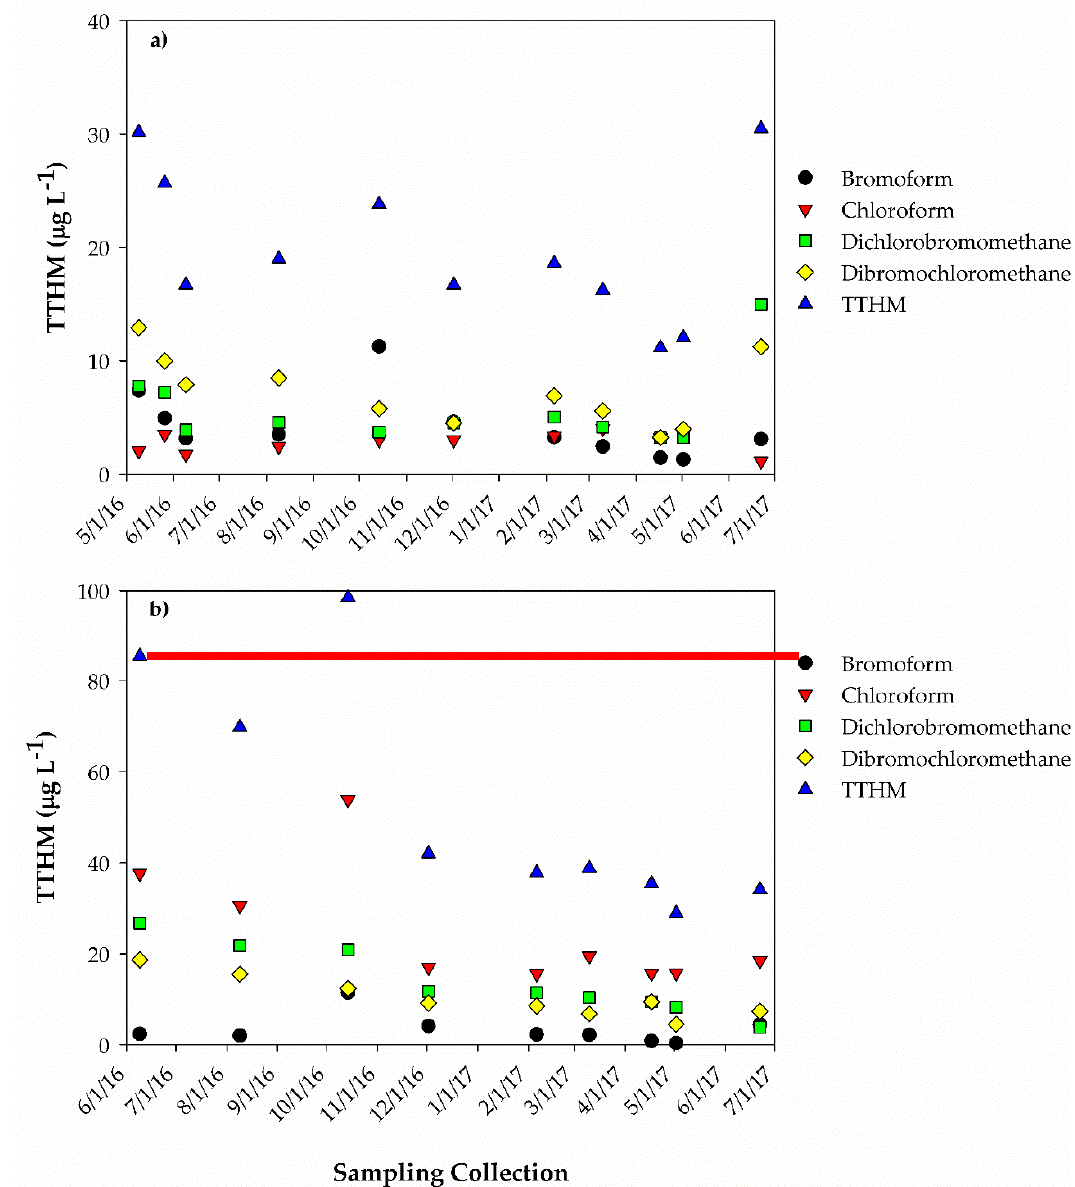
Figure 3. Total Trihalomethanes (TTHM) in ( a ) Auburn and ( b ) Nebraska City. Water samples were collected at the two water treatment plants after chlorination. Total TTHM maximum contaminant level (MCL): 80 µ g L − 1 (Stage 1 and Stage 2 Disinfectants and Disinfection Byproducts Rules. Available online: http://water.epa.gov/lawsregs/rulesregs/sdwa/stage2/regs_factsheet.cfm).